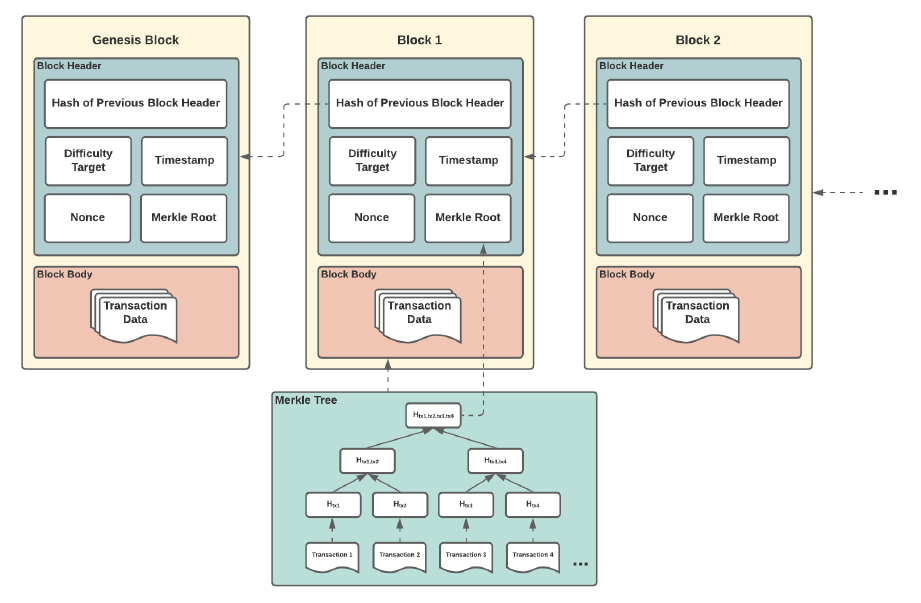
Figure 2. General blockchain data